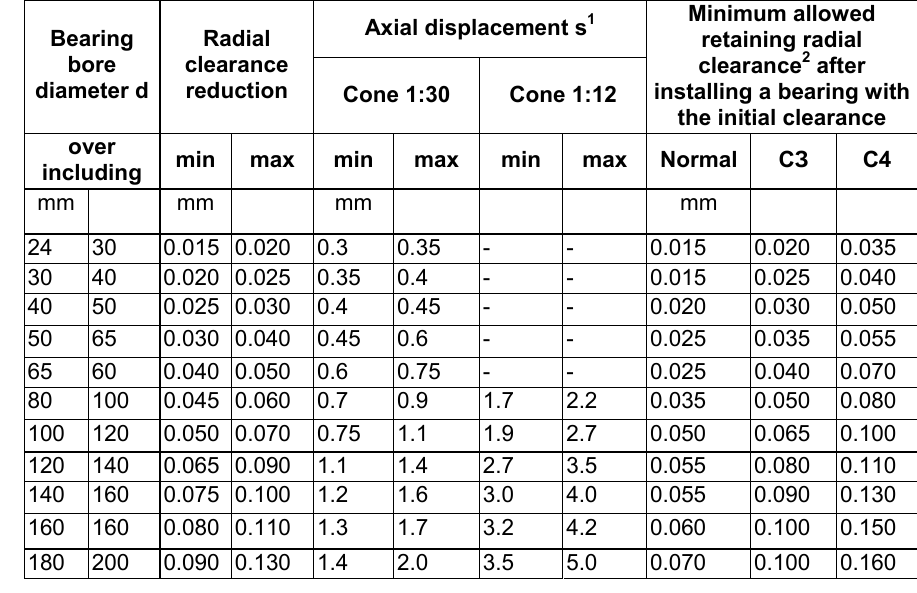
Figure 10 – 2-row barrel bearing with a bushing, Рисунок 10 – Изображение двухрядного подшипника с втулкой Слика 10 – Приказ дворедног бачвастог лежаја са чауром Table 2 – Data for a correct installation of a bearing Таблица 2 – Данные для правильной установки подшипника Табела 2 – Подаци за исправну монтажу